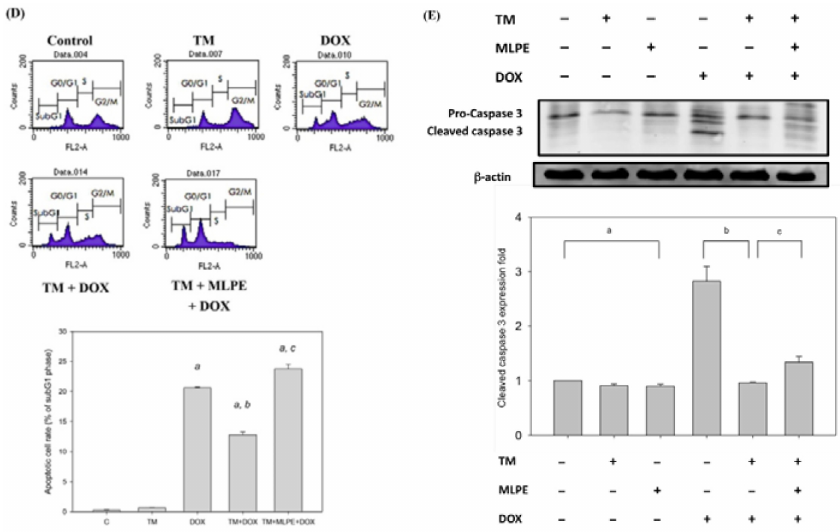
Figure 1. E ff ect of copretreatment with mulberry leaf polyphenol extract (MLPE) and tunicamycin (TM) on apoptosis induced by doxorubicin (DOX) in HepG2 cells. ( A ) HepG2 cells were pretreated with MLPE (0, 0.5, 1.0, 2.0, 3.0, and 4.0 mg / mL) for 24 h. a, p < 0.05, compared with HepG2 cells not